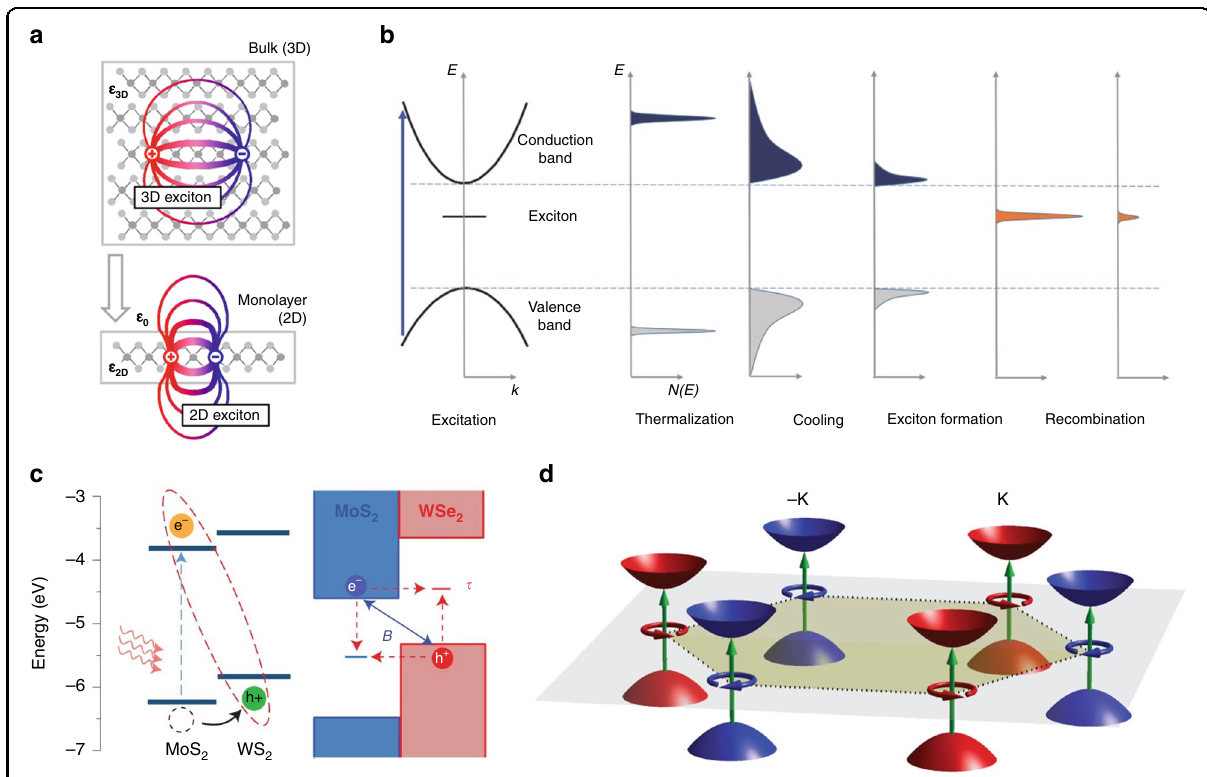
Fig. 1 Photocarrier relaxation dynamics in 2D semiconductors. a Real-space representation of electrons and holes bound into excitons for a 3D bulk and a quasi-2D monolayer. b Evolution of photocarriers after instantaneous interband excitation. c (Left) Schematic of the type-II band alignment of a MoS 2 /WS 2 heterostructure and the charge transfer process. (Right) Band pro fi le of a MoS 2 /WSe 2 heterostructure illustrating the mechanisms of interfacial recombination: the Shockley – Read – Hall (SRH) mechanism (red dashed arrow) and the Langevin mechanism (blue arrow). d Valley-contrasting optical selection rules in a 2D hexagonal lattice with broken inversion symmetry. Figure reproduced with permission from a ref. 24 , © 2014 American Physical Society; b ref. 22 , © 2016 WILEY ‐ VCH Verlag GmbH & Co., KGaA, Weinheim; c ref. 29 , © 2014 Springer Nature and ref. 31 ,